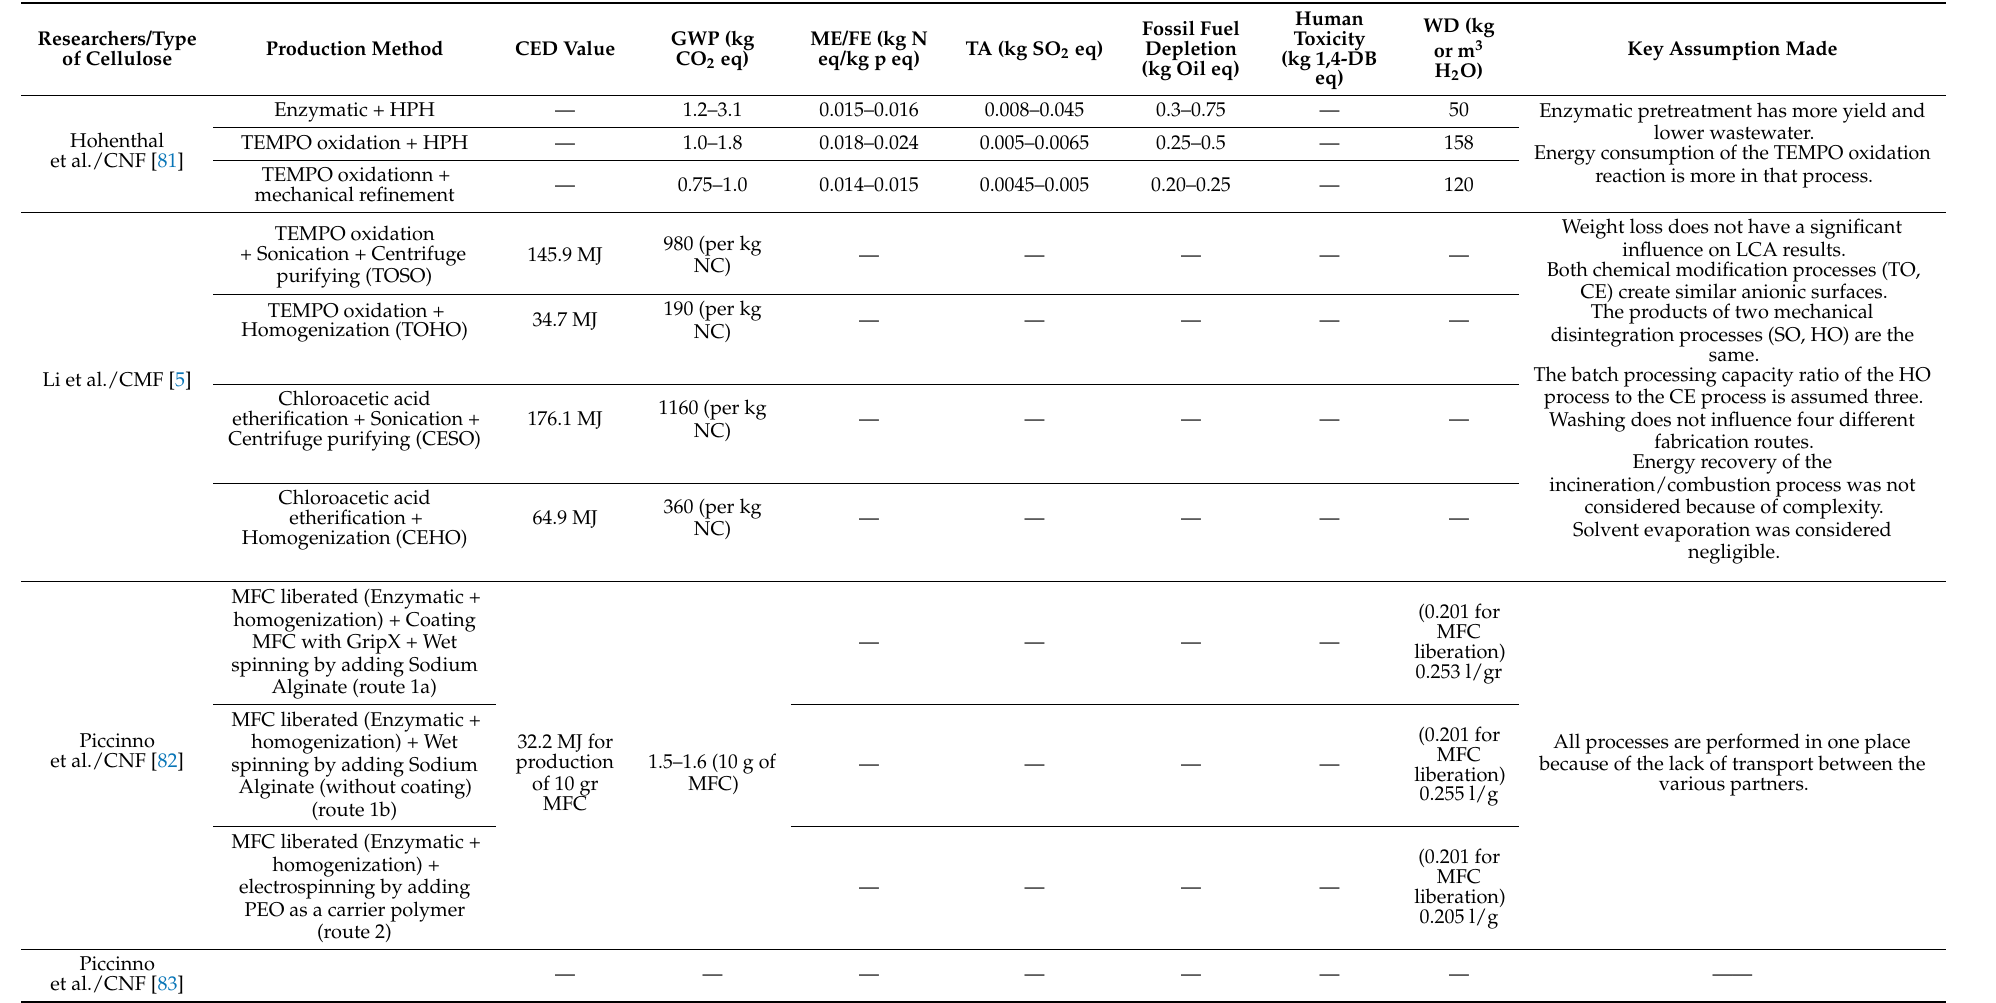
Table 4. A summary of LCA findings of nanocellulose products, including cumulative energy demand and climate change from